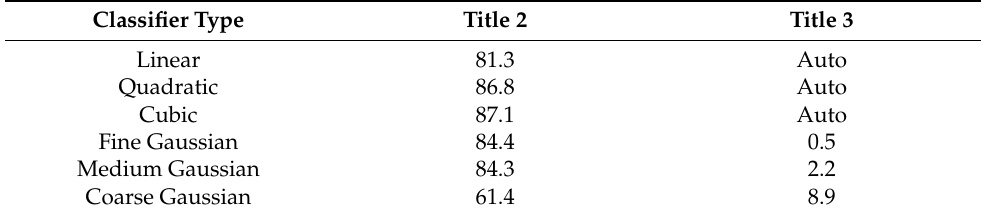
Table 2. Accuracy by applying a polynomial kernel.